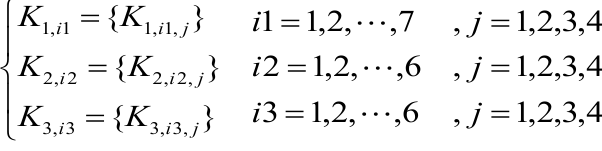
Figure 13. The procedure for determining an optimal evaluation